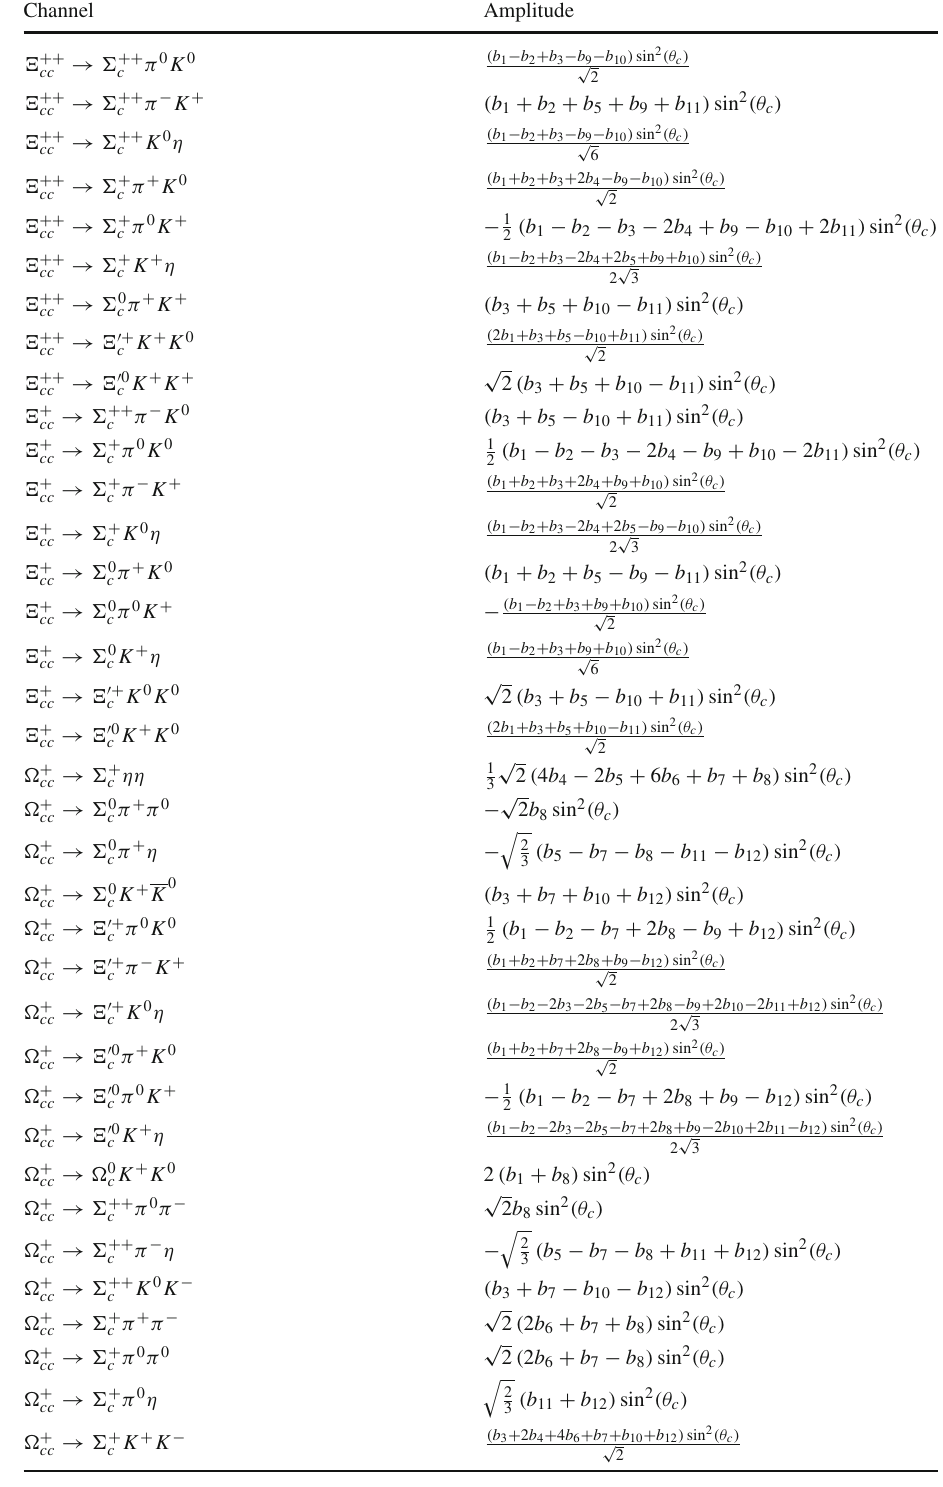
Table 10 Doubly charmed baryon decays into a sextet cqq and two light